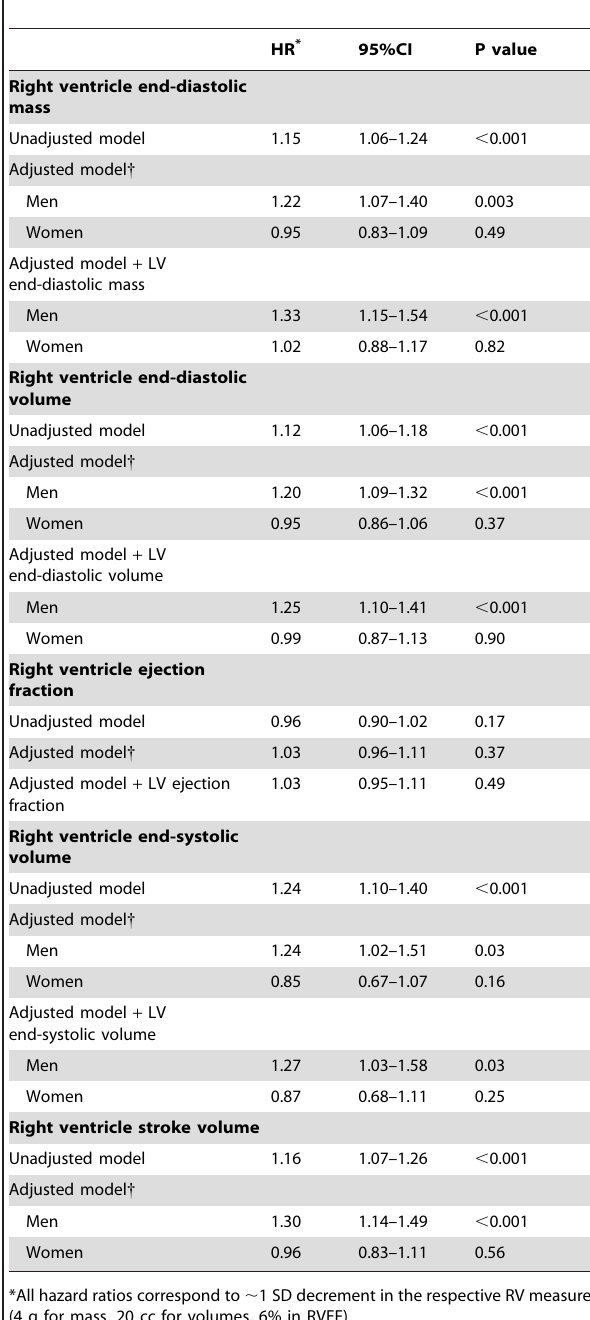
Table 2. Mean RV and LV measures stratified by gender. Variable